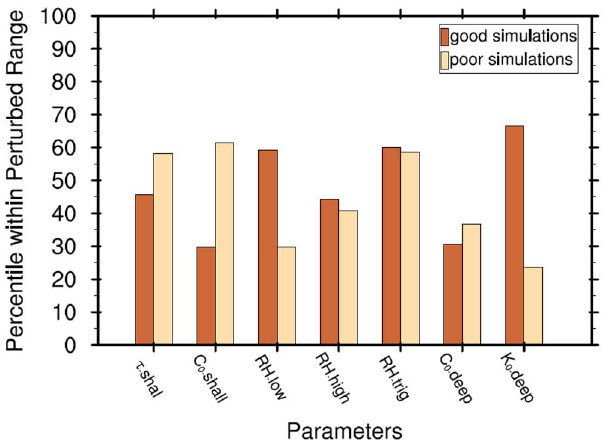
Figure 6. Average values of 7 chosen parameters in good and poor simulations in form of each parameter value’s percentile within its perturbing range (maximum-minimum) as in Table 1.